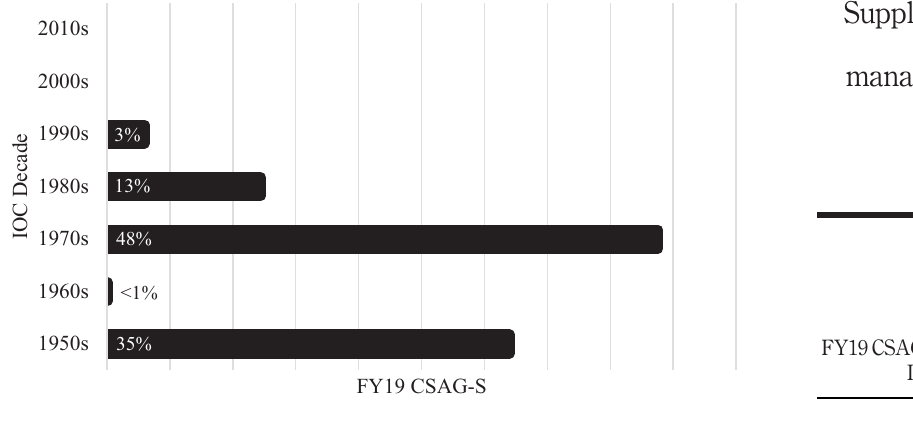
Figure 2. FY19 CSAG-S by